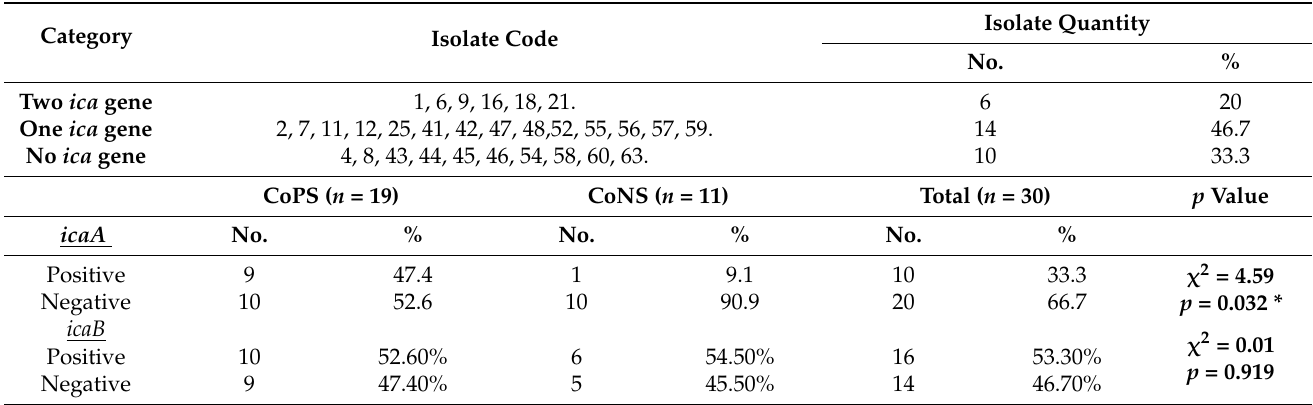
Table 5. Relative detectability of icaA and icaB genes in PCR results within the tested staphylococci species isolated from patients.